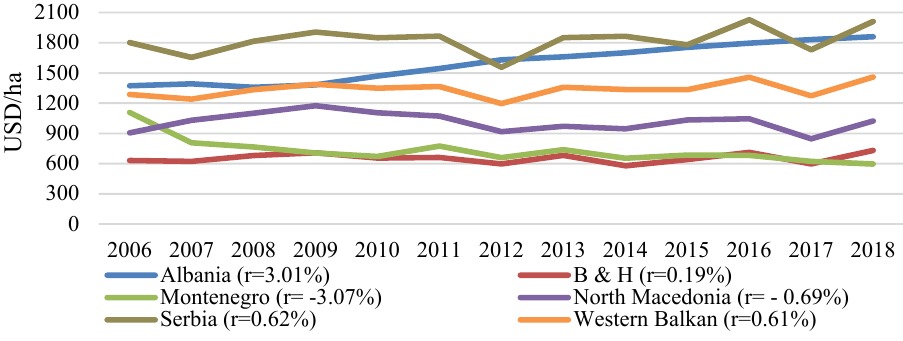
Figure 1. Land productivity in Western Balkans countries. Source: own research on basis of FAOSTAT.